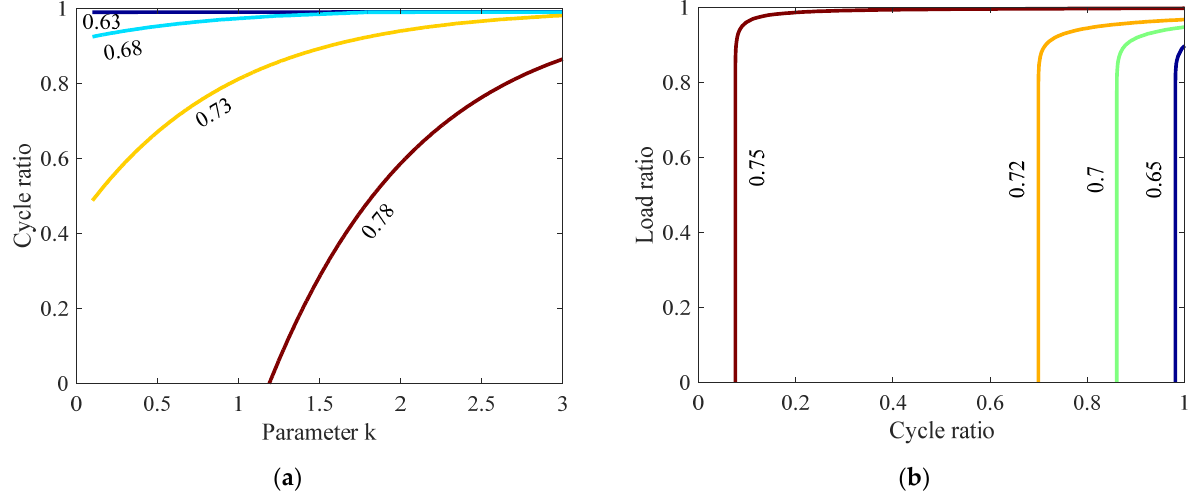
Figure 3. Contours of physics-based Model I. ( a ) Cycle ratio = 0.3. ( b ) Parameter k = 1.5. When the cycle ratio is 0.3, the contours of Model I concerning the loading ratio and variable k are shown in Figure 3a. It can be observed that the loading ratio and k both have